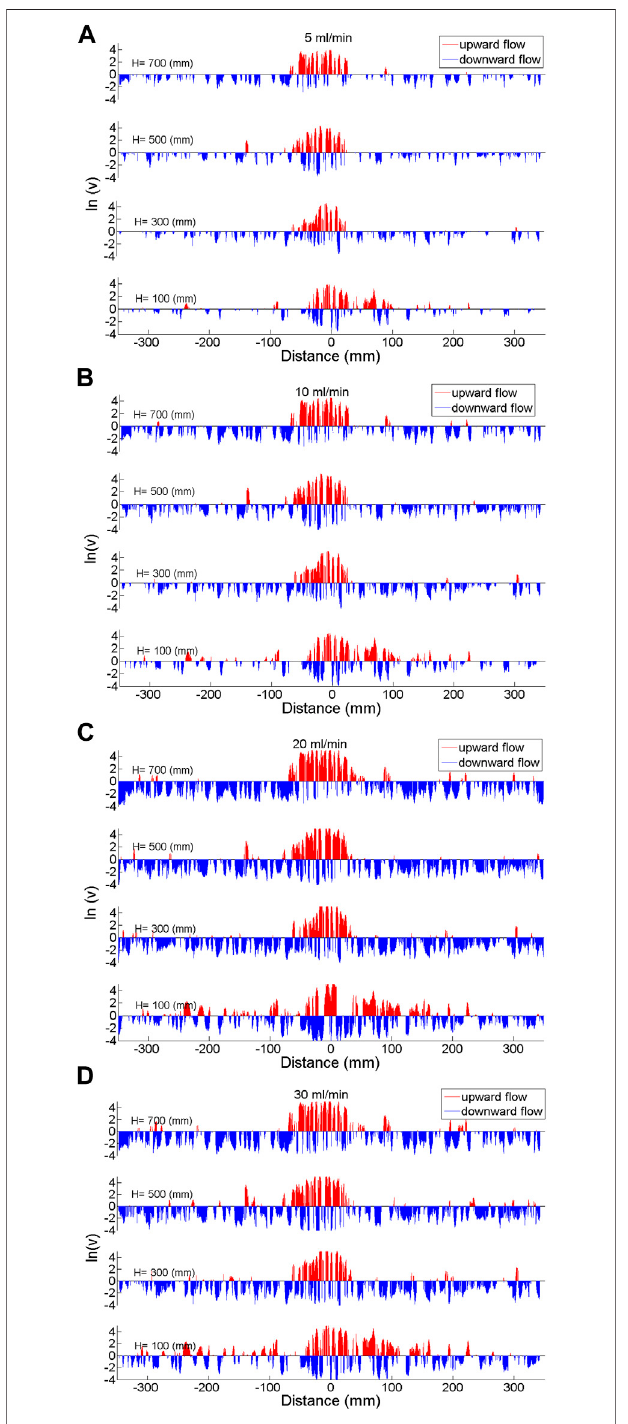
FIGURE 9 | The bubble plume-induced pore-water velocity (ln (v) ) in the vertical direction under various gas release rates: (A) 5 ml/min; (B) 10 ml/min; (C) 20 ml/min; (D) 30 ml/min. The red lines represent the upward pore water fl ow, and the blue lines show the downward pore water fl ow.